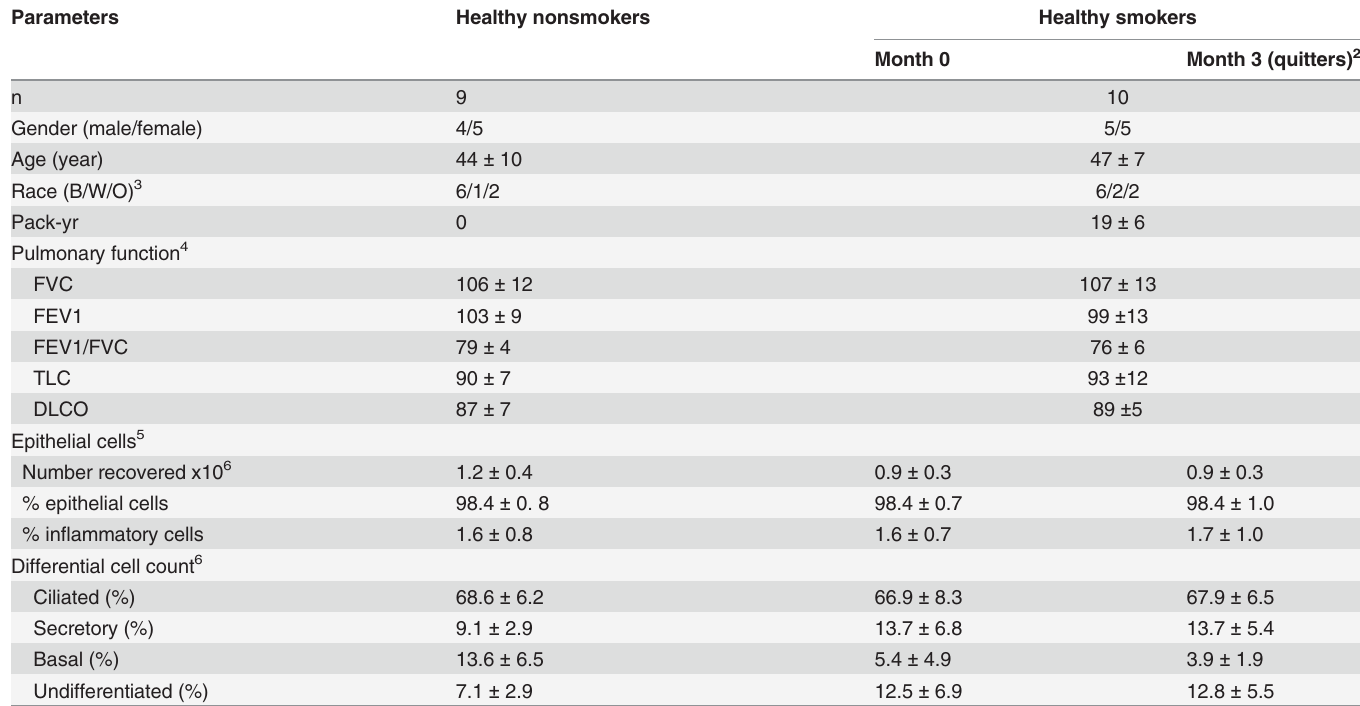
Table 1. Demographics of healthy nonsmokers, healthy smokers and healthy smokers after 3-month smoking cessation 1 .